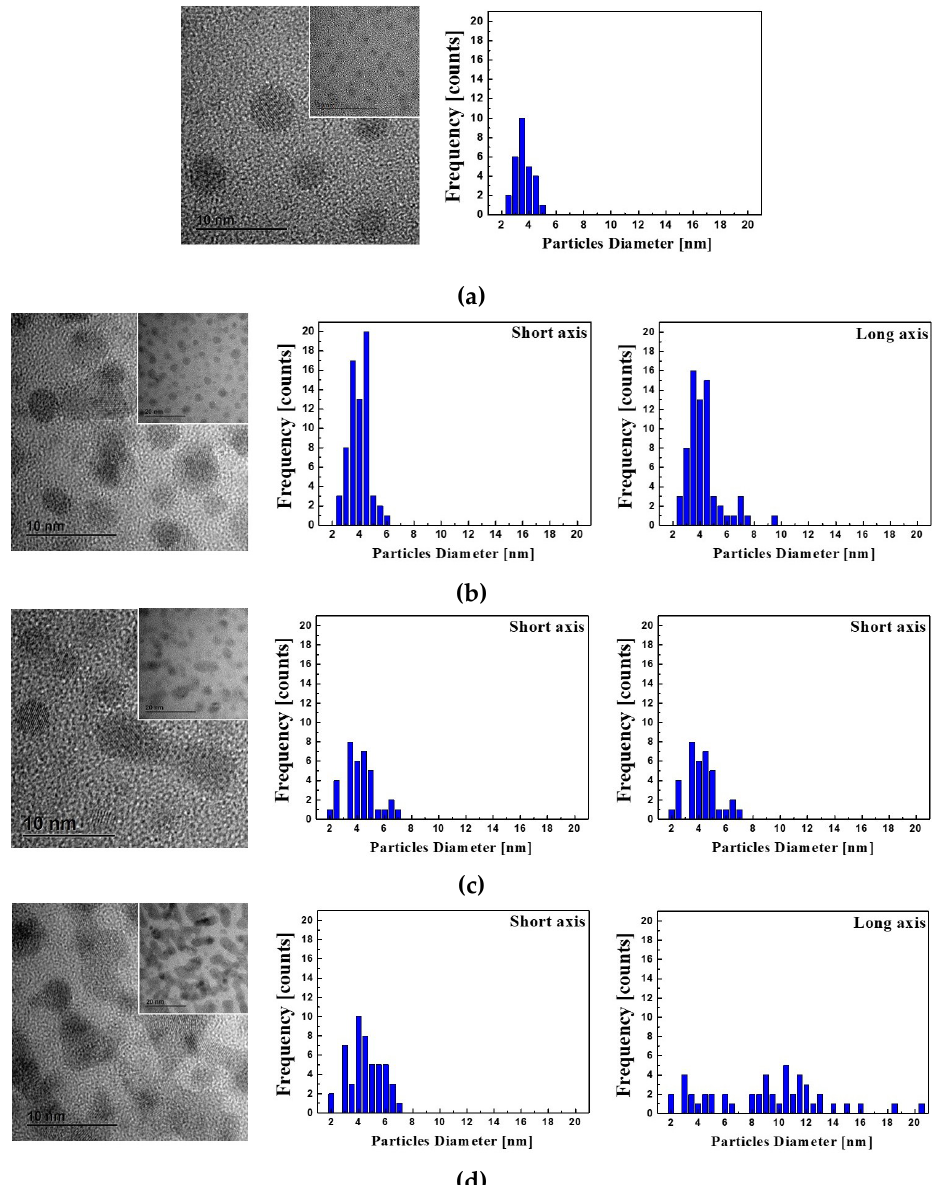
Figure 2. TEM images and size distribution of the major and minor axis lengths of the Au NPs incorporated in the cladding of the fiber ( a ) before and after the γ -ray irradiation at the total dose of ( b ) 1190 Gy, ( c ) 2380 Gy, and ( d ) 3570